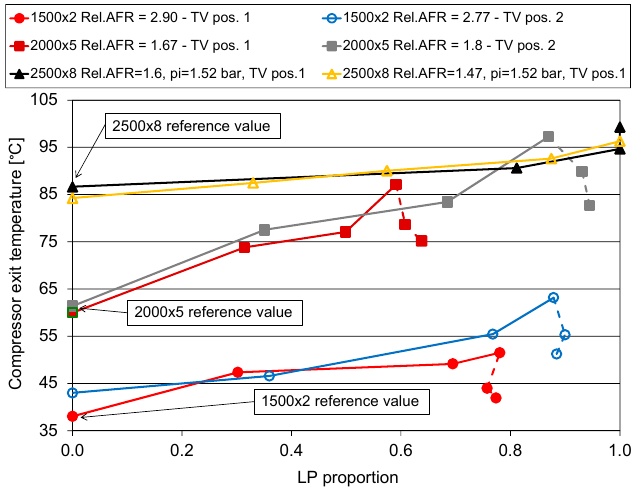
Figure 5. Compressor exit temperature as a function of LP proportion in different operating modes.